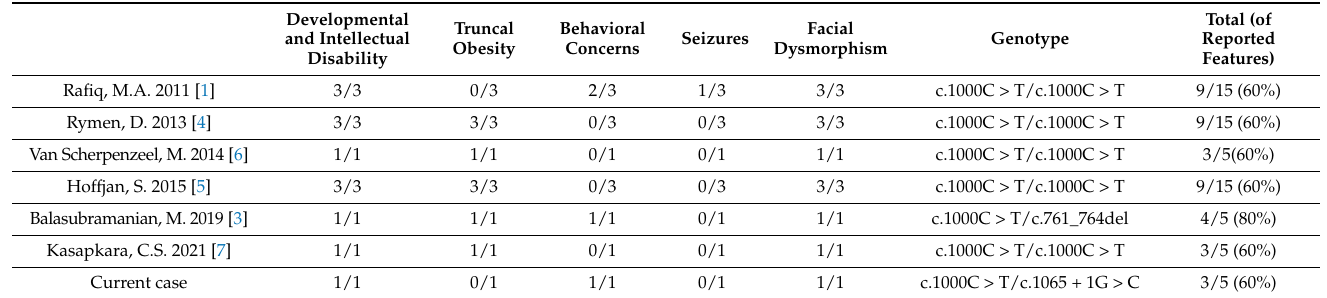
Table 1. Patients’ clinical descriptions with a c.1000C > T mutation in other